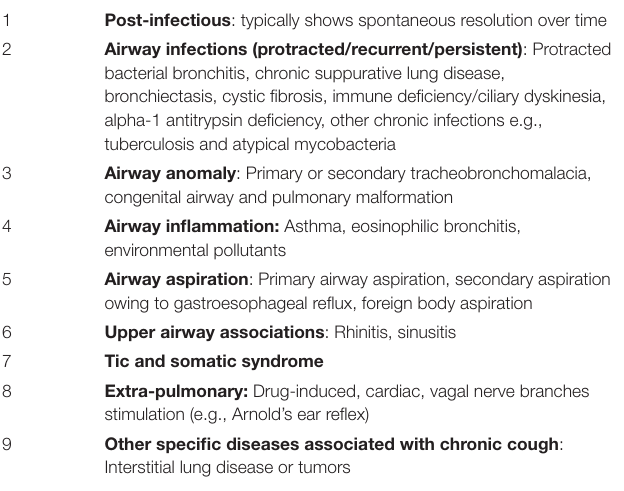
TABLE 2 | Major aetiological causes of chronic cough in children * and